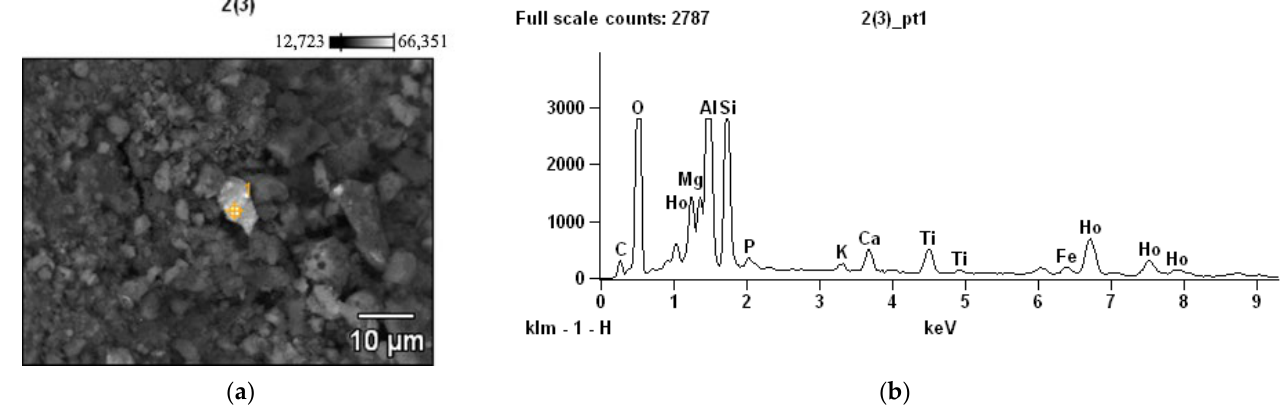
Figure 16. Microscopic: ( a ) and ( b ) X-ray fluorescence results of aluminosilicate particles. The specific surface of the enriched aluminosilicate product after grinding by an Ac- tivator-4M planetary mill is 1597.2 m 2 /kg and the bulk density is 900 kg/m 3 . Enrichment